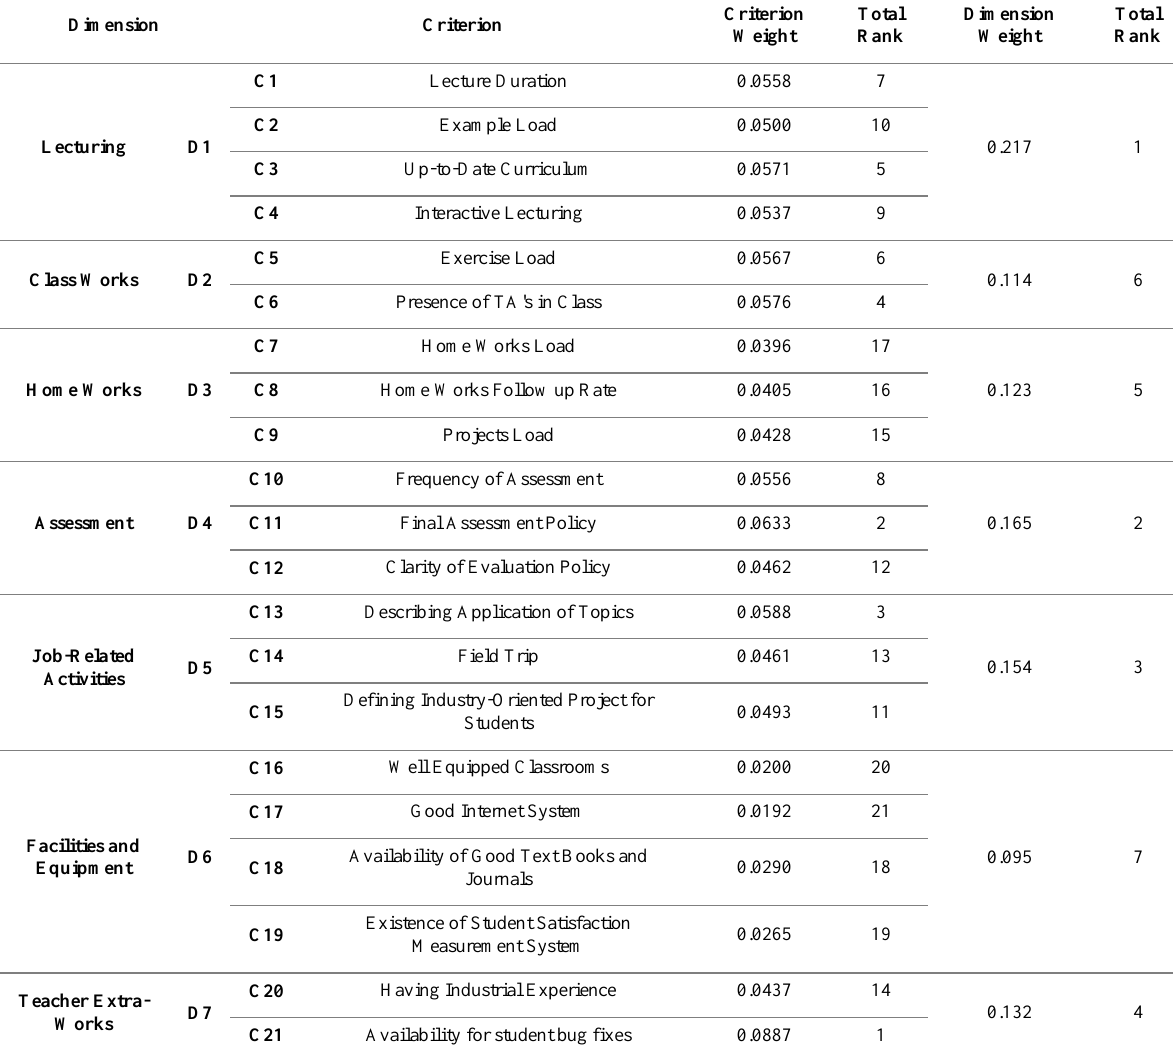
Table 15. Final weights for criteria and